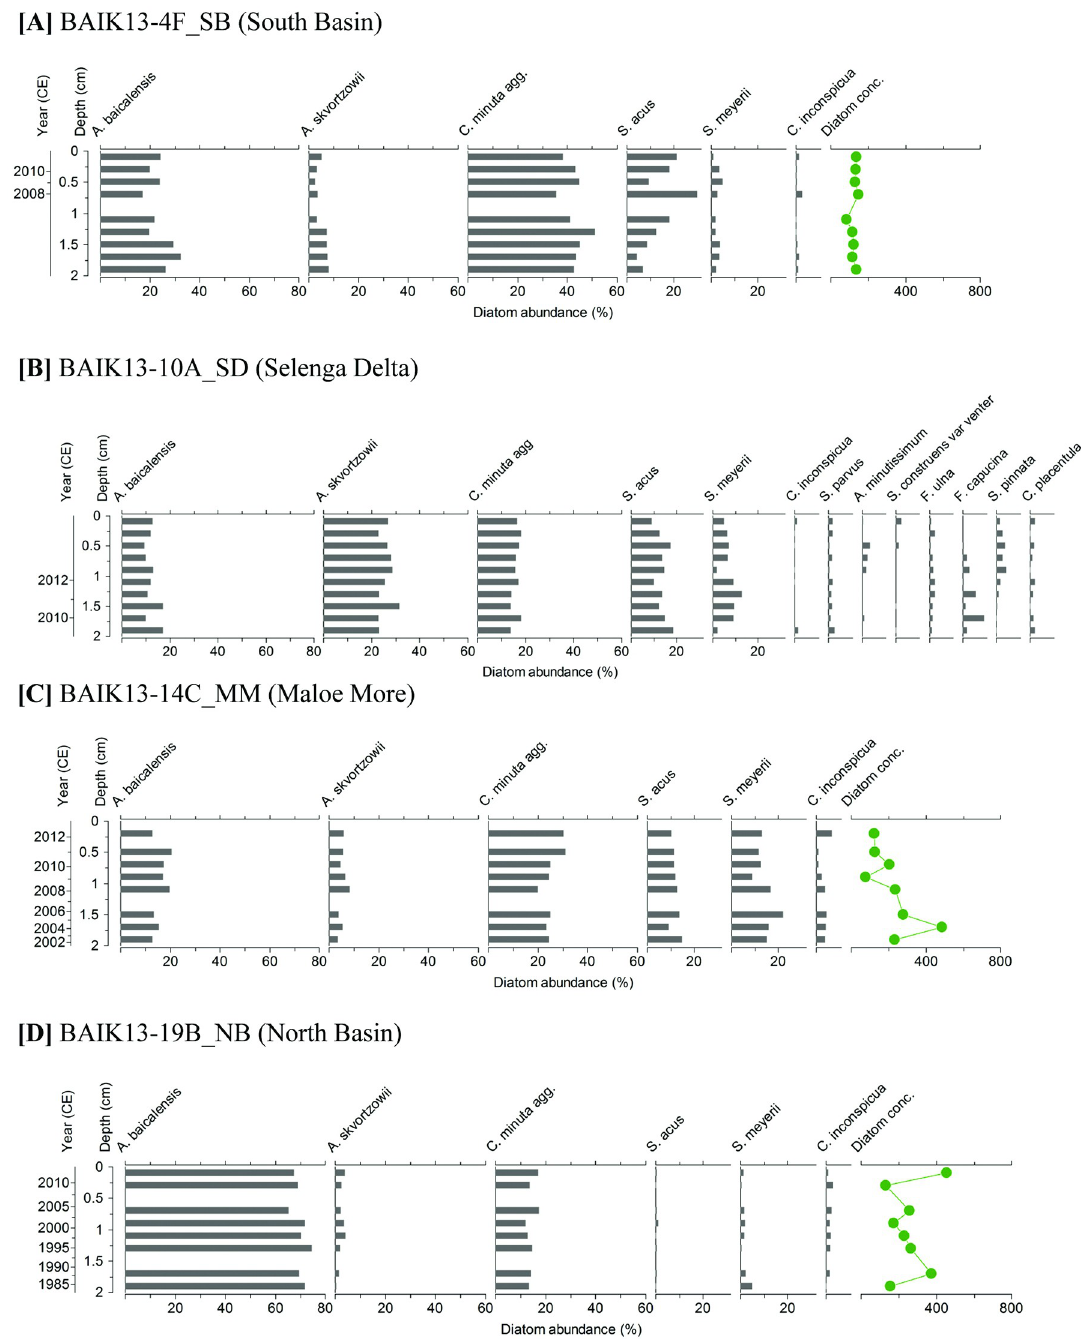
Fig 4. Stratigraphic plots of core top diatom assemblages are shown for (A) BAIK13-4F_SB, (B) BAIK13-10A_SD, (C) BAIK13- 14C_MM, (D) BAIK13-19B_NB. Diatom concentrations (10 4 valves/g DW) are shown alongside diatom abundances (species with > 2% abundance). [SB: South basin; SD: Selenga Delta; MM: Maloe More; NB: North basin].